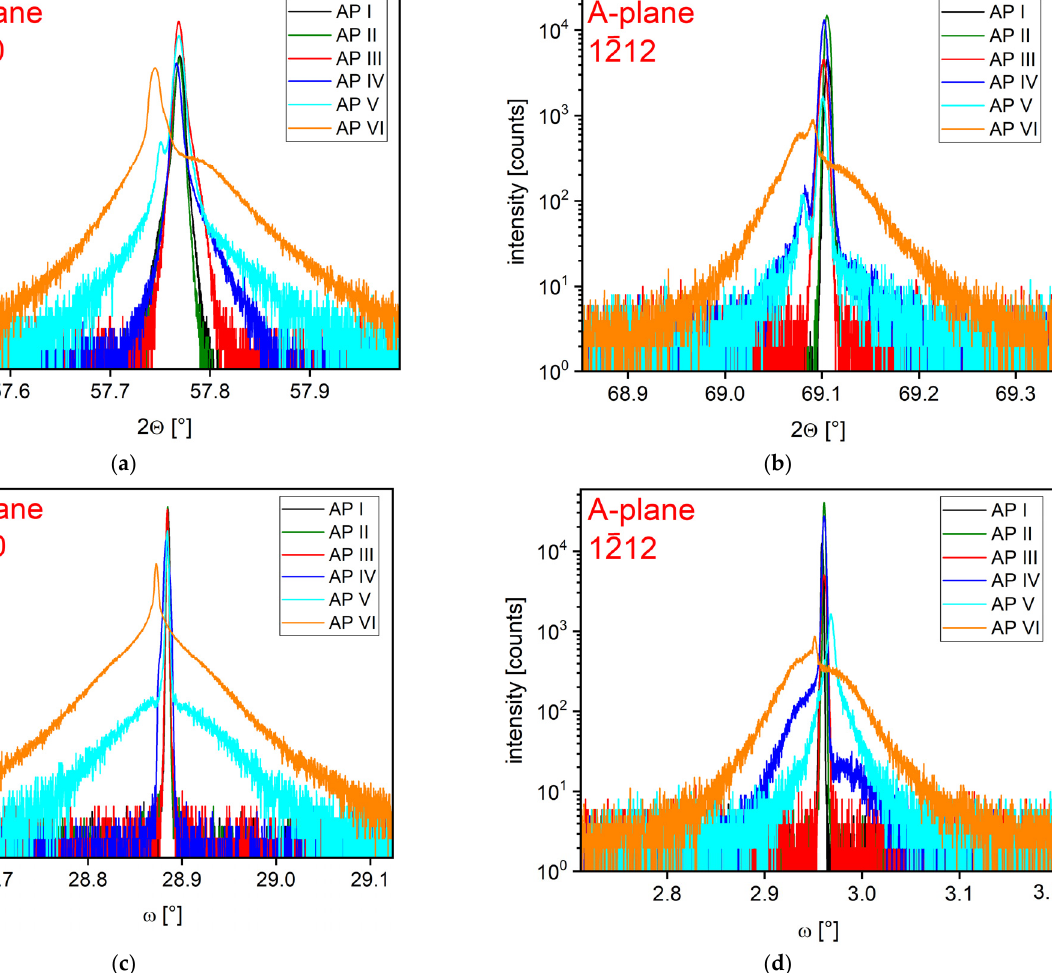
Figure A3. HRXRD scans performed for the 1210 slice: ( a ) 2 θ / θ scan for reflection 1210, ( b ) 2 θ / ω -scan for reflection 1212, ( c ) ω -scan for reflection 1210 and ( d ) ω -scan for reflection 1212. Analysis positions (APs) and growth areas: AP I—area (4)—center of the seed, AP II—area (4)—in the middle of the radius, AP III—area (1)—seed, AP IV—area (4)—close to the edge of the crystal, AP V—area (2) and AP VI—area (3).